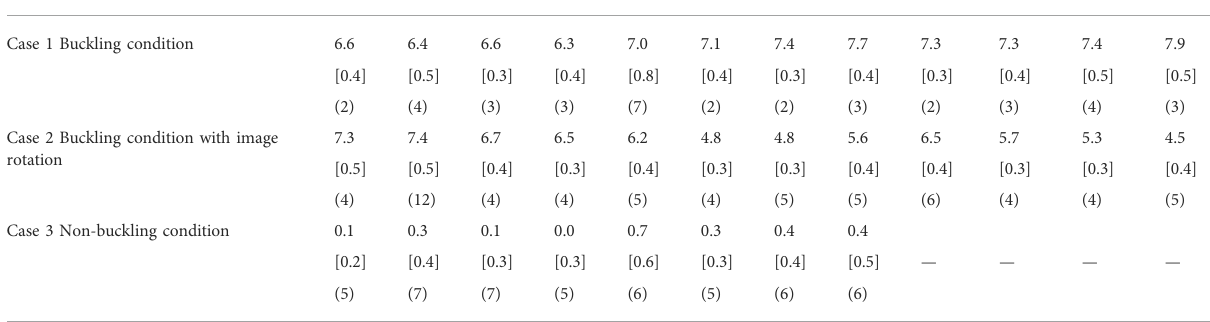
TABLE 2 Analyzed angles of in-service steel sheet piles by digital image analysis with Hough